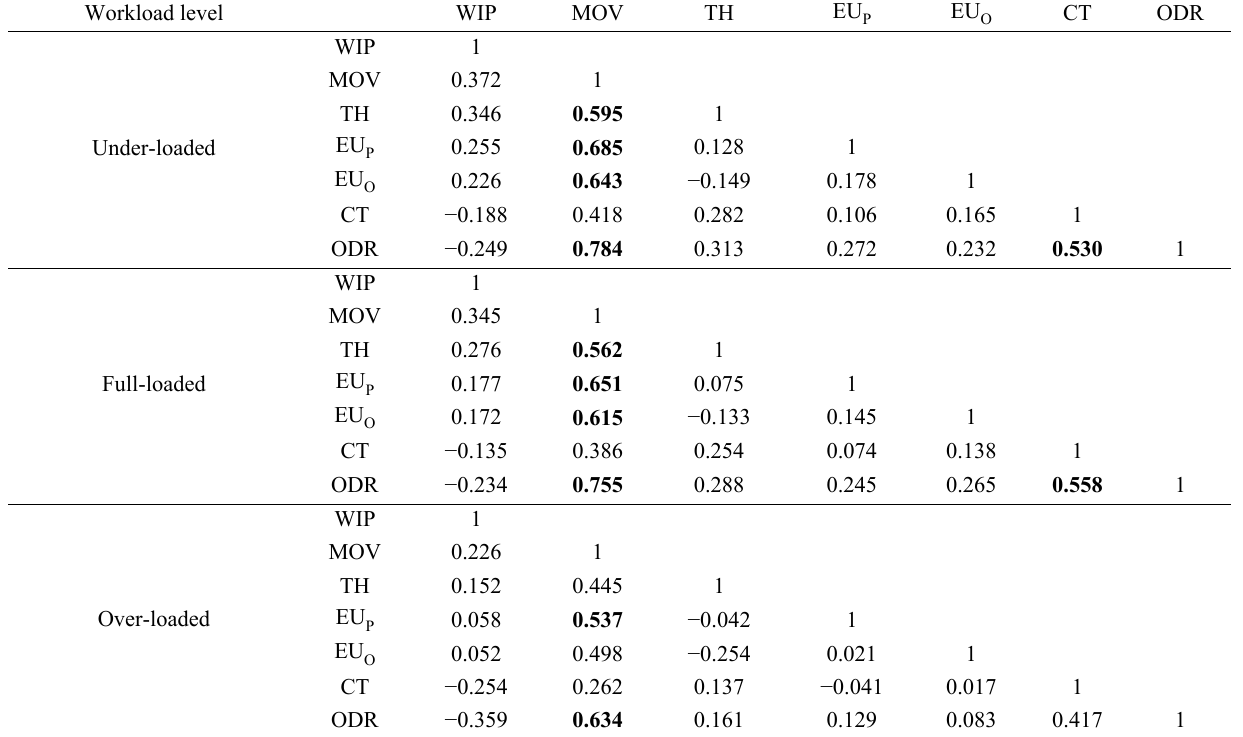
Table 3 Correlations among performances in different workload